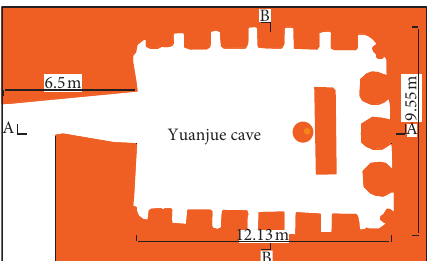
Figure 2: Structure characteristics of Yuanjue Cave in top view.